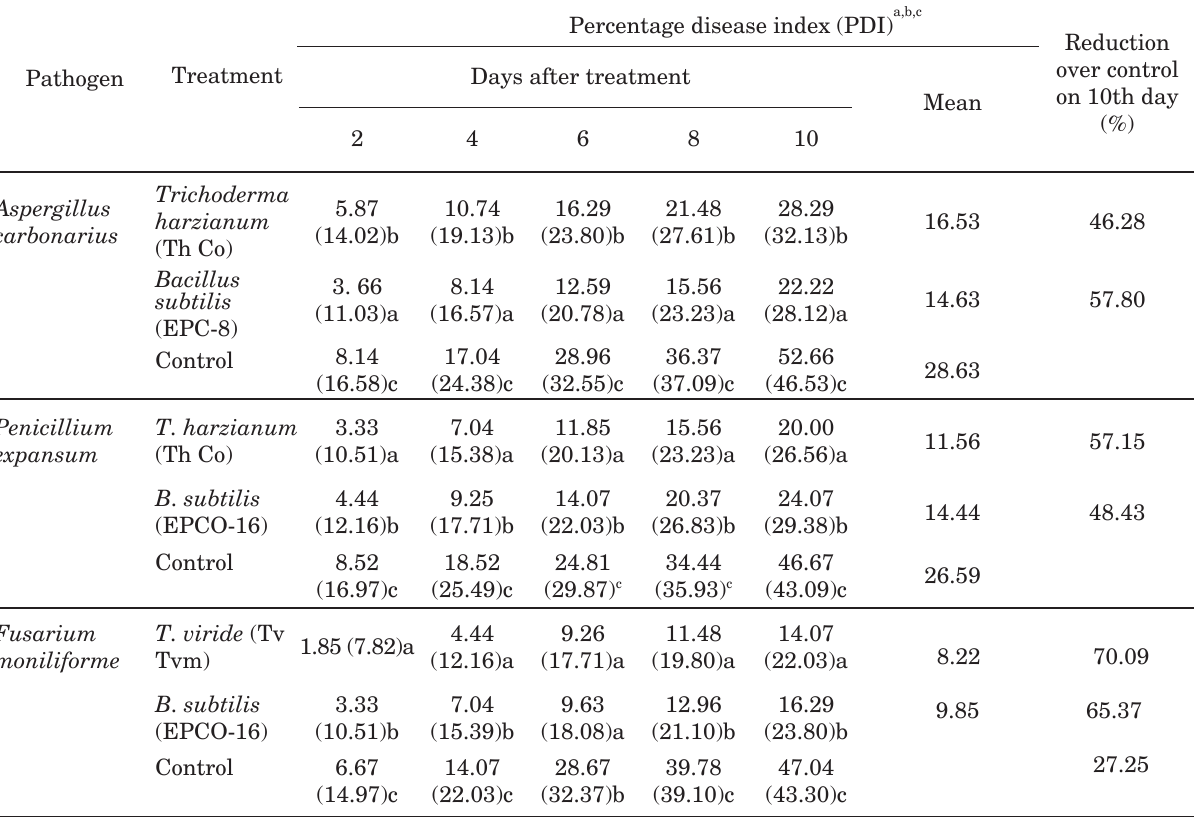
Table 1. Efficacy of biological agents on postharvest pathogens of grapes in vitro.